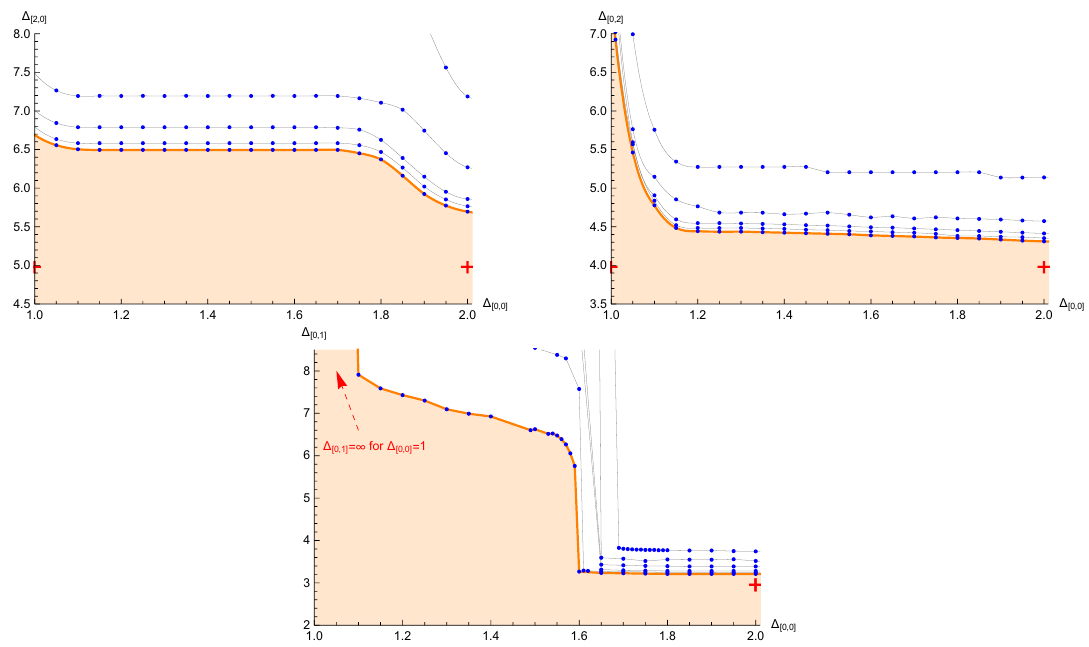
Figure 4 . Upper bounds for (cid:1) Gap structures coming from the analytic solutions (C.1) for special values of the parameters are shown with red crosses. Among them there is an analytic solution for which (cid:1)